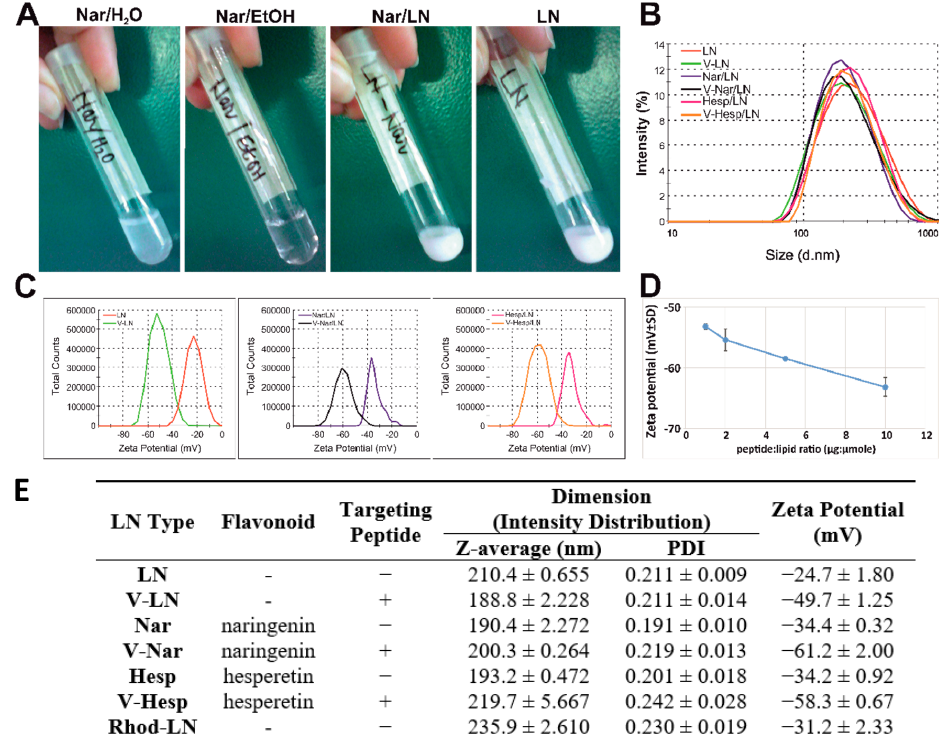
Figure 1. Physico-chemical characterization of flavonoid-loaded lipid nanoemulsions. ( A